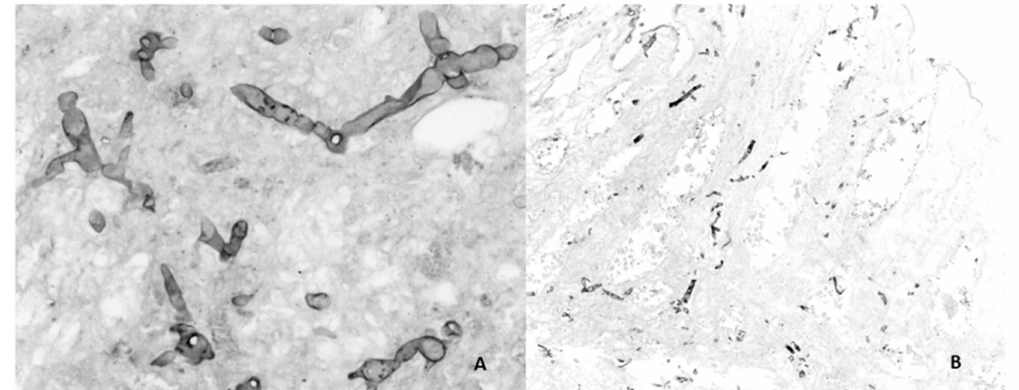
Figure 2. ( A ) Non-pigmented, separated hyphae with acute angle branching in liver biopsy tissue, Grocott methenamine silver-stained specimen, 40 × . ( B ) Non-pigmented, separated hyphae with acute angle branching in intestinal tissue, Grocott methenamine silver-stained specimen, 10 ×